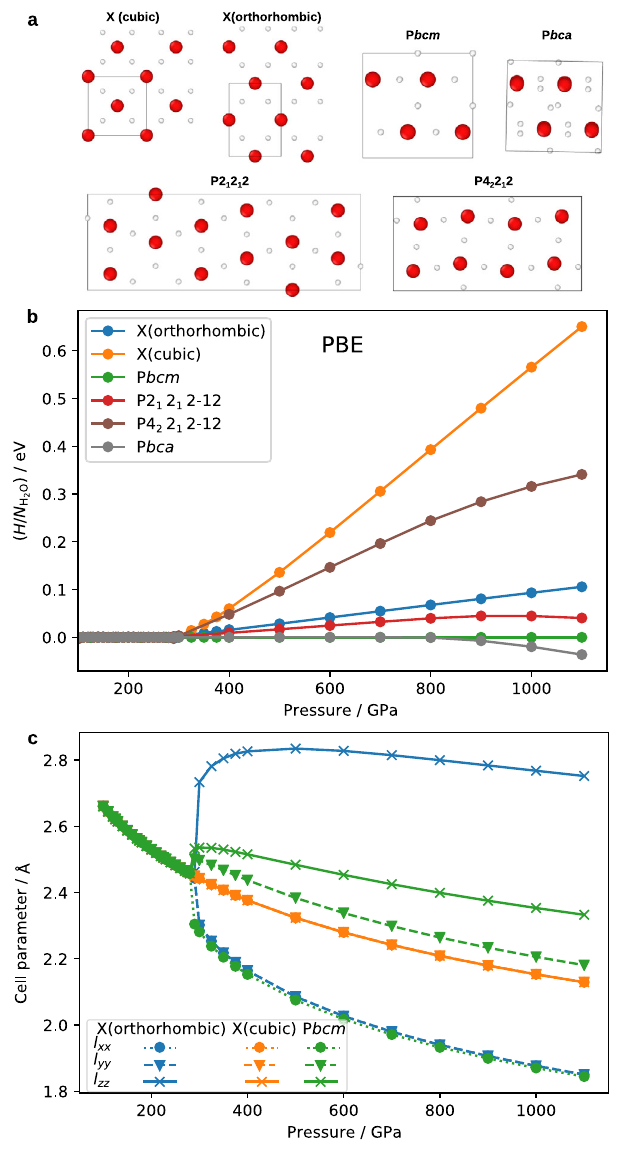
Fig. 2 | Structures and properties of high-pressure phases at 0K. a The struc- tures of the ice phases considered. The simulation supercells used in DFT calcu- lations are indicated using black boxes. b 0K enthalpy curves for different ice phasespredictedbythePBEDFTfunctional. c Thelengthoftheedgevectorsofthe simulationsupercell( l xx , l yy and l zz )forX(orthorhombic),X(cubic)andP bcm phases at 0K. All three cell parameters for X(cubic) are the same, so the three orange curvesoverlap;twoedgelengthsfortheX(orthorhombic)cellarethesame,sotwo blue curves overlap; and for P bcm there are three different cell parameters. The simulation supercells used for X(cubic) and X(orthorhombic) have 2 water mole- cules,whiletheP bcm supercellhas4molecules(seepanel a ),sothecellparameters for the P bcm supercell in two directions have been divided by